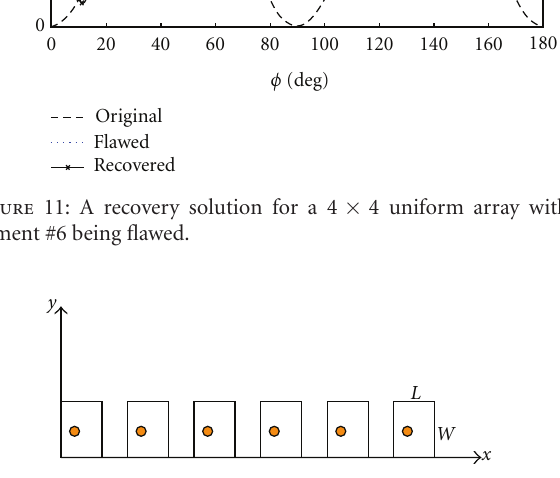
Figure 12: A schematic of a linear array of probe-fed rectangular microstrip antennas placed along x